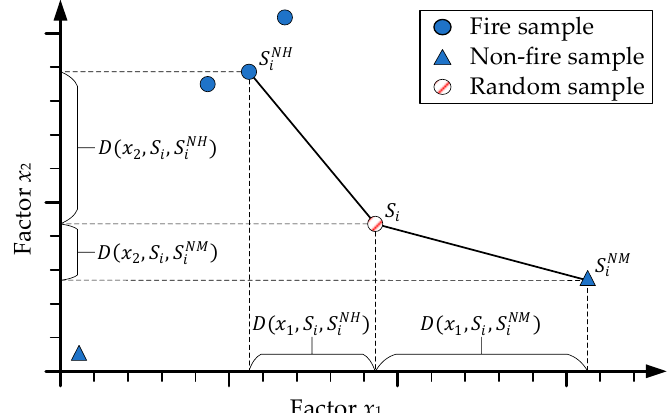
Figure 2. Basic idea of Relief